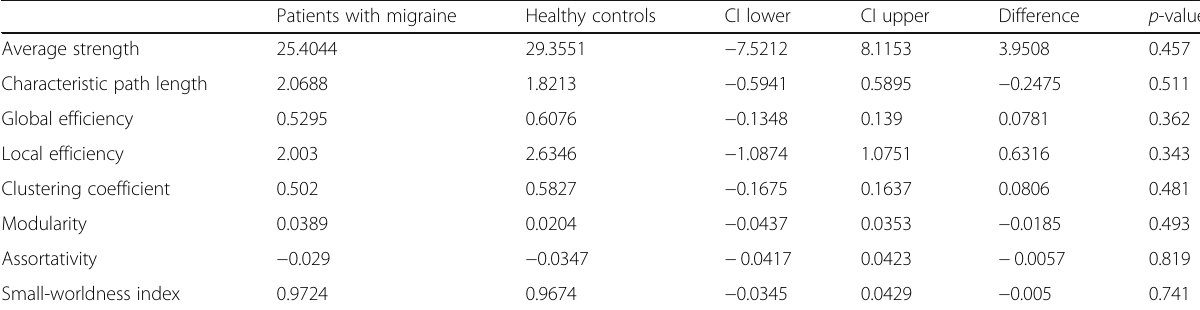
Table 3 Differences in the intrinsic thalamic network between the patients with migraine and healthy controls Patients with migraine Healthy controls CI lower CI